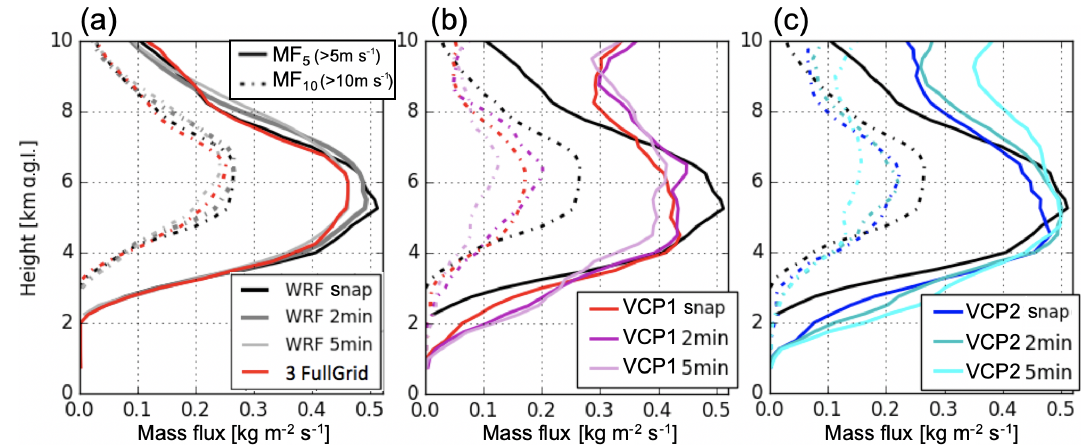
Figure 10. Vertical profiles of convective mass flux with updraft thresholds of 5ms − 1 (solid lines) and 10ms − 1 (dashed lines). Displayed in each panel are different retrieval simulations represented by the colors. The dark gray line in (a) represents the time average of the WRF output over 2min, and the light gray line in (a) represents the time average of the WRF output over 5min. The profile from the WRF snapshot is displayed in each panel by a black solid line. Adapted from Oue et al.